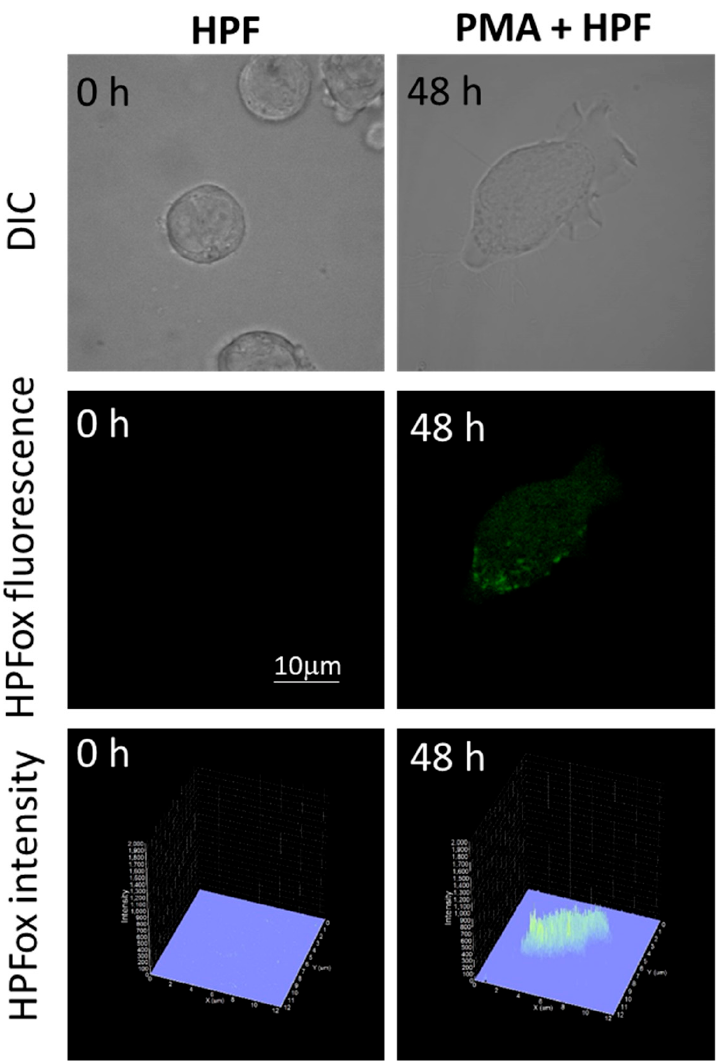
Figure 6. Hydroxyl radical imaging in HL-60 cells. The cells were incubated with 1 µM HPF for 12 h in the absence ( left panel ) and presence ( right panel ) of 50 nM PMA. The incubation in PMA was done for 48 h. Images from DIC channel and HPF-ox fluorescence (green signal) are presented. The lower panel shows the integral distribution of the signal intensity within the sample ( Z -axis represents the levels of brightness for each pixel, ranging between 0 and 2000).